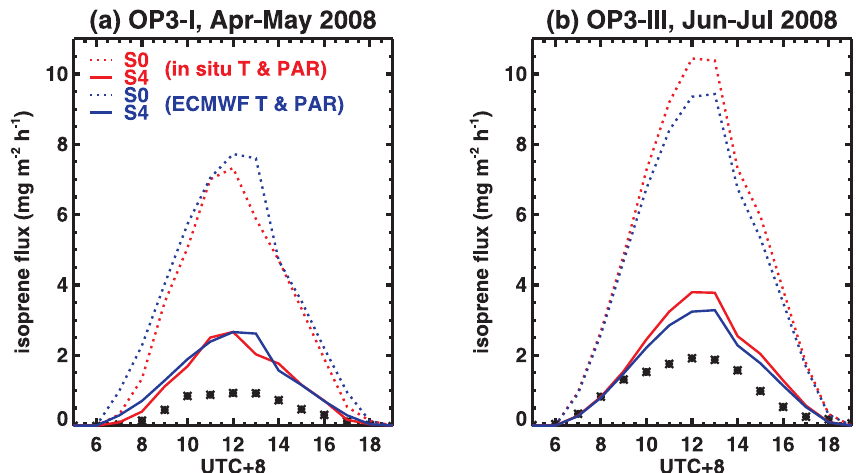
Fig. 11. Average diurnal profile of measured isoprene fluxes (black symbols) during (a) phase 1 and (b) phase 2 of the OP3 field campaigns (Langford et al., 2010) compared with calculated profiles from the S0 and S4 simulations using meteorological fields from either in situ measurements (Fig. 6b in Langford et al.) or ECMWF ERA-Interim data (Table